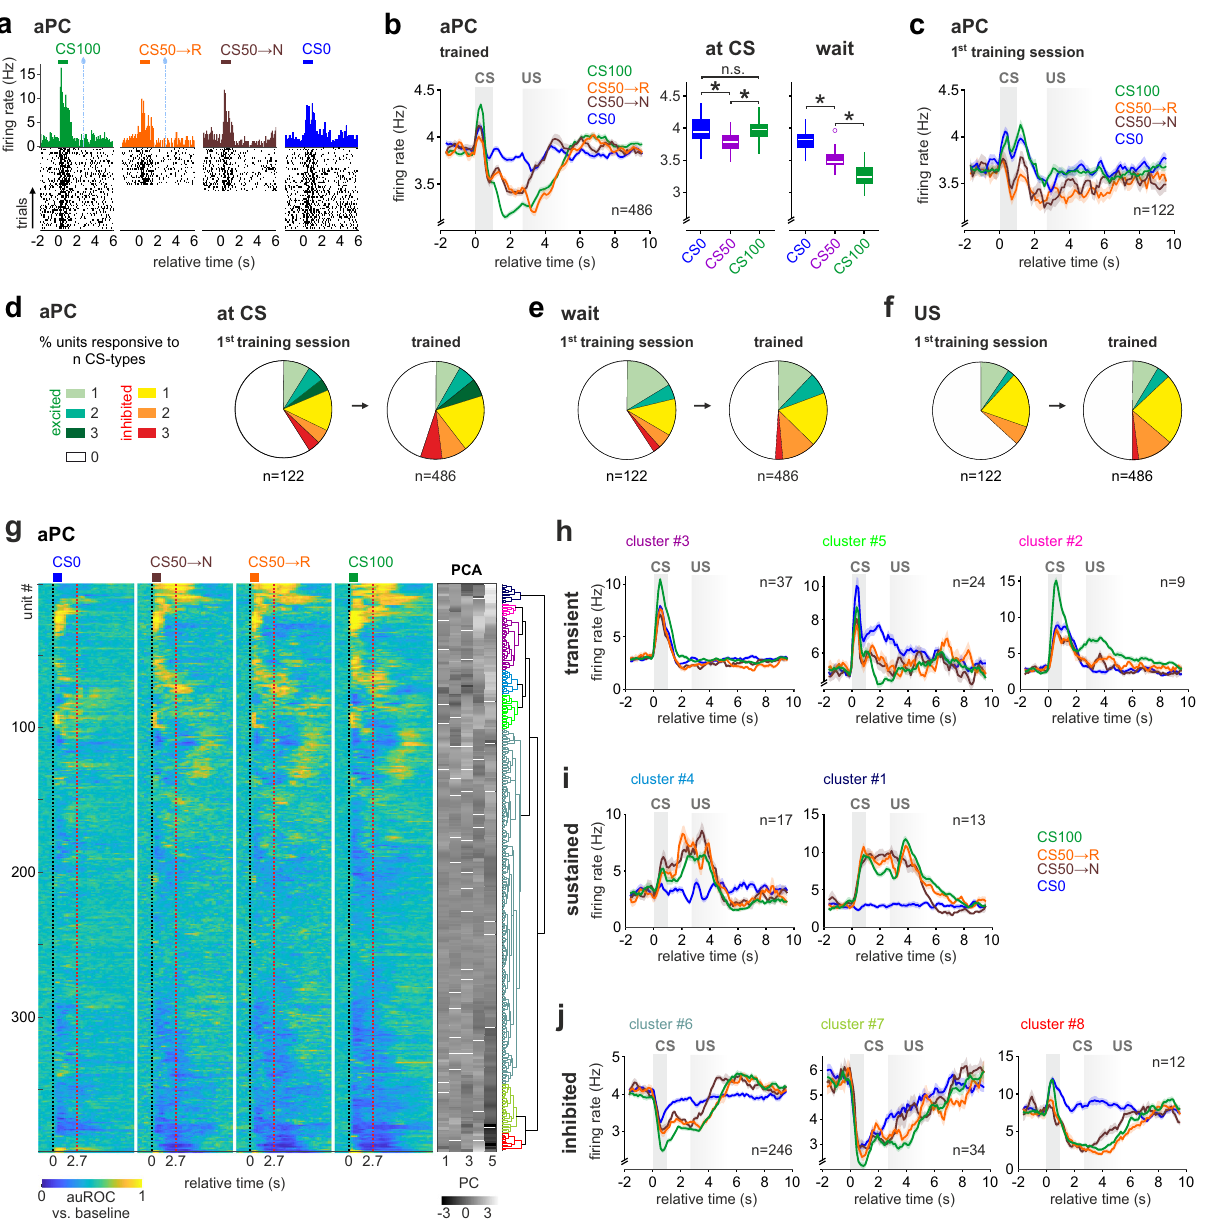
Fig. 6 Task-inhibited value responses dominate aPC. a Example of single-unit fi ring activity in aPC in trained animals. Peri-stimulus time histogram (PSTH) and spike raster plots showed stable task-related responses. b Task-related mean fi ring rate evolution ± SEM in aPC units. After a fi rst detection peak at CS, aPC displayed monotonic RP during the waiting period as a progressive decrease in fi ring rate. Right: Box plots showing median aPC fi ring rates for CS and waiting period ( n = 486 units; one-way ANOVA with Tukey post hoc comparisons). The bounds of the boxes represent 25th to 75th percentiles. Lower and upper whiskers represent minimum and maximum values without outliers; outliers indicated by circles. * indicates P < 0.05 (see Supplementary Table 1 for P values and test details). Source data are provided as a Source Data fi le. c Task-related mean fi ring rate evolution ± SEM in aPC units in the fi rst training session. Note the more balanced net fi ring rate during the waiting period. d – f Fraction of single units showing signi fi cant task- excited, task-inhibited, or no responses to either one or more trial types (CS0, CS50, CS100) at CS ( d ), during wait ( e ), and at US ( f ). Unit responsiveness was tested against baseline (Friedman test, P < 0.05 with Benjamini – Hochberg correction). The fraction of task-inhibited units increased after training. The fraction of excited units, as well as their level of selectivity to one or more trial types, remained relatively stable. g Classi fi cation of aPC units into functional clusters. Unit responsiveness during different trial types was quanti fi ed by auROC. (left) Hierarchical clustering was performed on the fi rst fi ve principal components (center, grayscale) of the auROC traces and revealed eight prominent task-response clusters (right). h – j The task-response clusters identi fi ed in ( g ) were grouped according to their responsiveness at CS and during the waiting period. We identi fi ed three major groups with ( h ) task-excited transient activity at CS, ( i ) task-excited sustained activity during waiting, and ( j ) task-inhibited responses. Displayed mean fi ring rate ± SEM. The color of the titles matches the cluster color in the dendrogram in ( g ). Unlike the task-inhibited cluster, none of the task-excited clusters displayed a monotonic RP (see Supplementary Fig. 7f – h). n indicates the number of